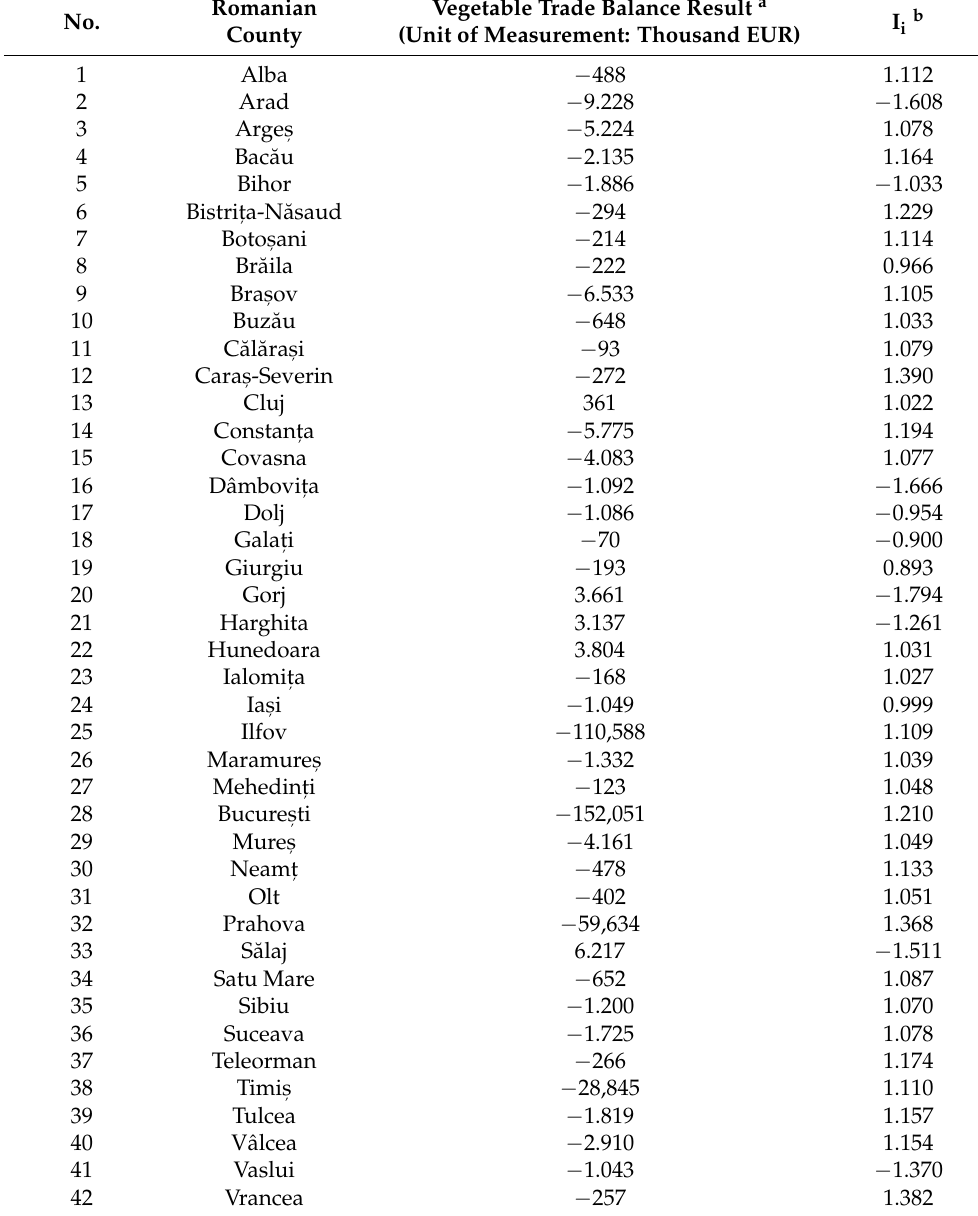
Table 7. County-level trade balance results with vegetables and the mean dynamic (I i